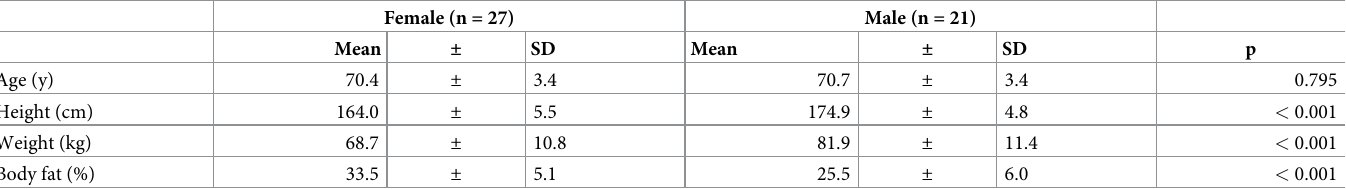
Table 1. Descriptive data for the participating participants. P-values are from an independent samples t-test.